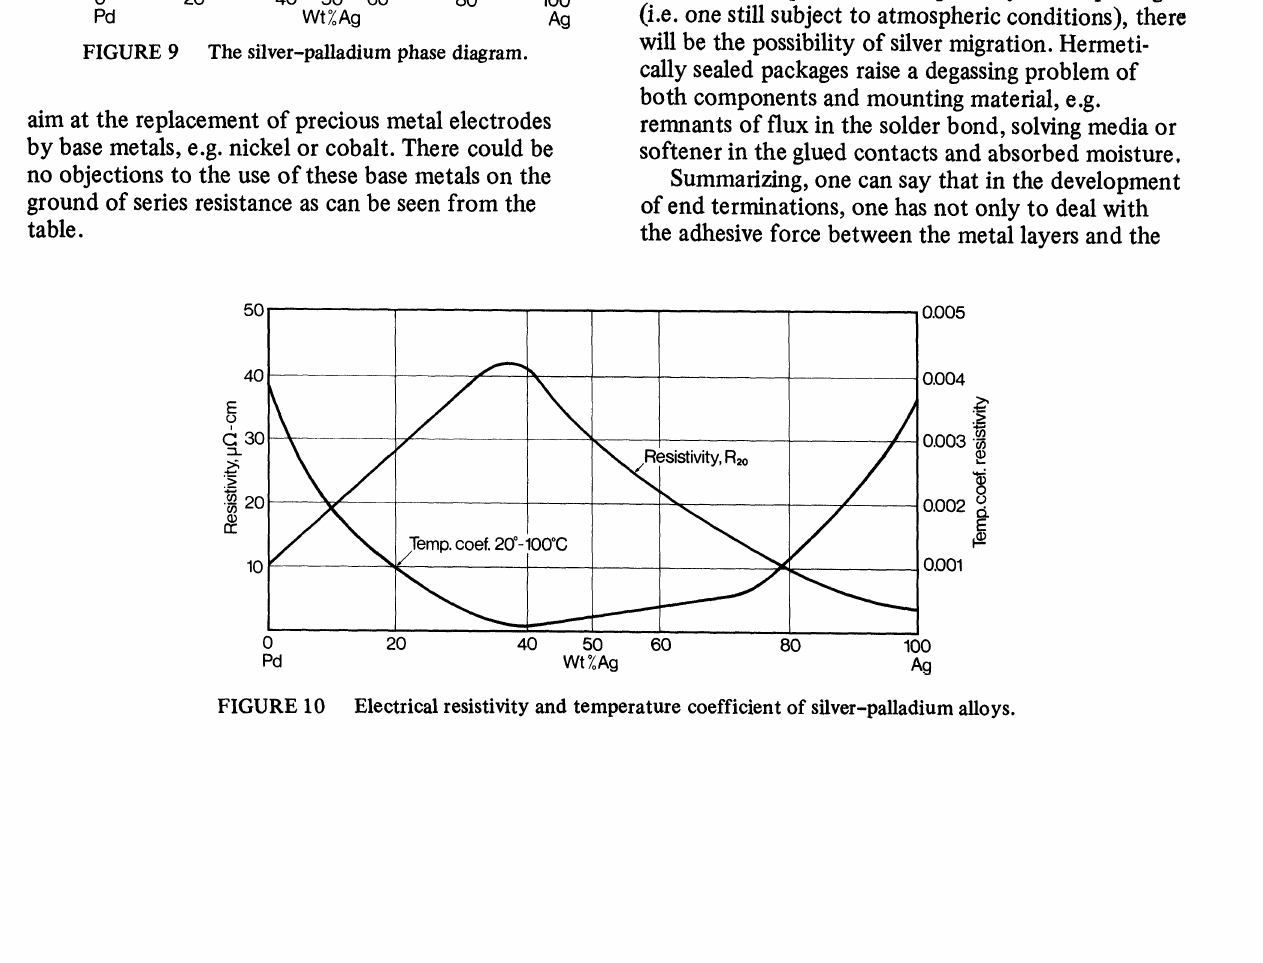
FIGURE 9 The silver-palladium phase diagram. aim at the replacement of precious metal electrodes